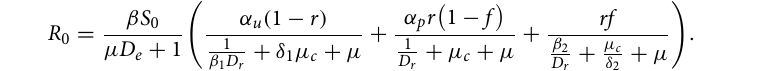
Table 2. Summary of corrected number of cases, estimated underreporting factor, case-fatality rate based on reported cases and infection-fatality rate across different testing scenarios. Population size of Delhi is obtained from https:// censu sindia. gov. in/, and the testing, infection, recovery and fatality data are extracted from https:// covid 19ind ia. org/. (a) The URF is the ratio of the estimated number of true cases and the corrected number of reported cases. For the IFR, we report the estimate if we adjusted for 10 × death underreporting (10 × adj.). (b) The URF is the ratio of the estimated number of true cases and the corrected number of reported cases. For the IFR, we report the estimate if we adjusted for 5 × death underreporting (5 × adj.). adj. adjusted, CFR case-fatality rate, est. estimated, IFR infection-fatality rate, URF underreporting factor.